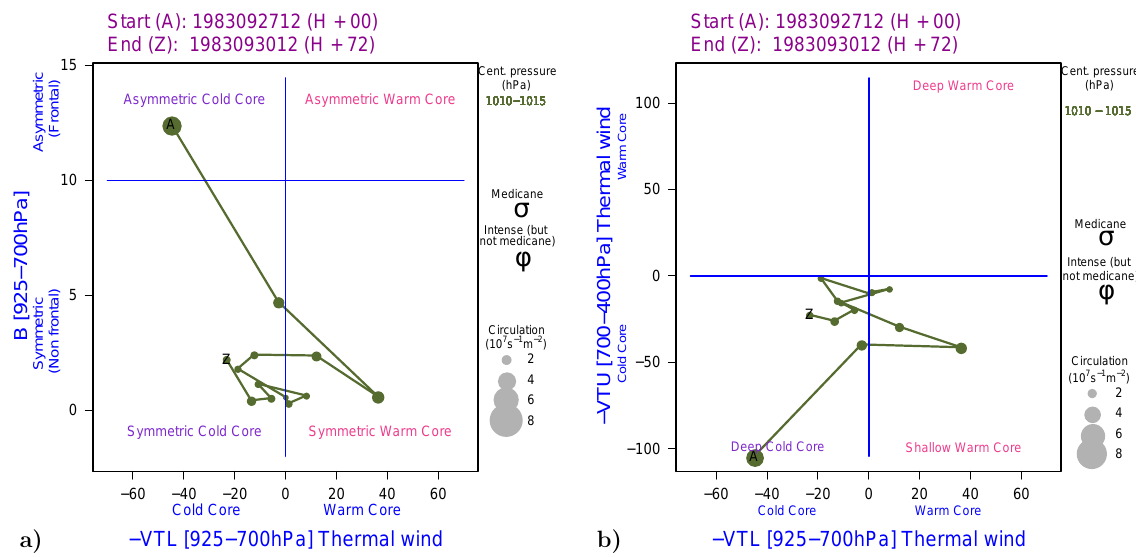
Fig. 5. Cyclone phase diagrams I (a) and II (b) , as Fig. 3, for September 1983 event